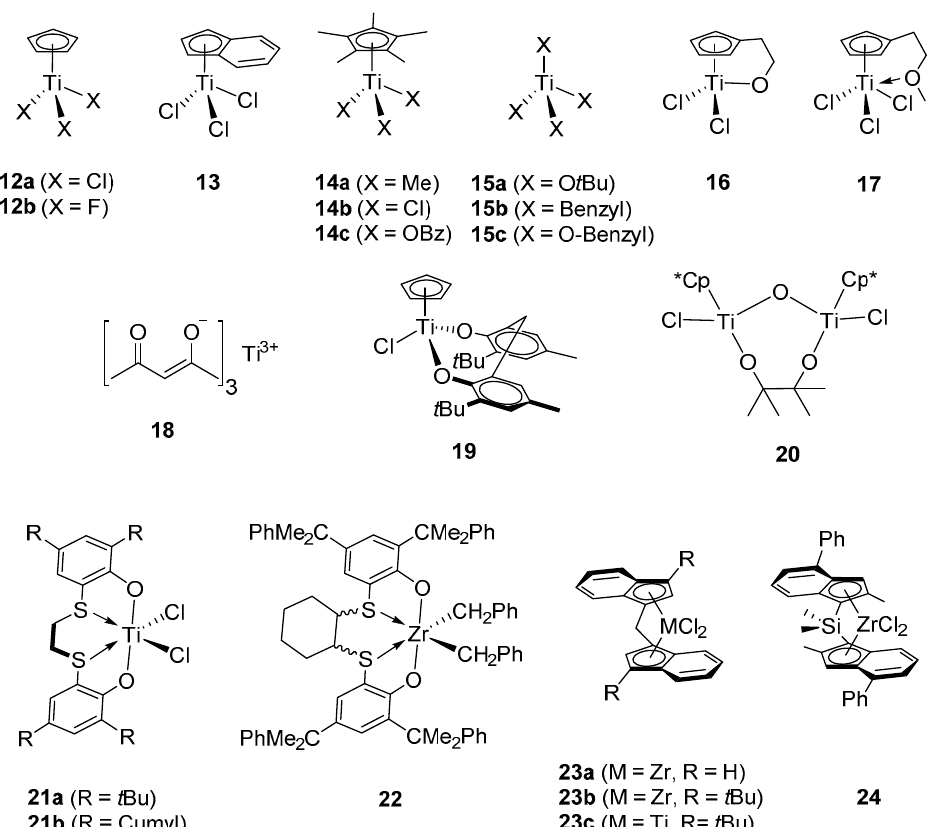
Figure 2. Group 4 metal catalyst precursors used for stereoselective styrene copolymerizations.